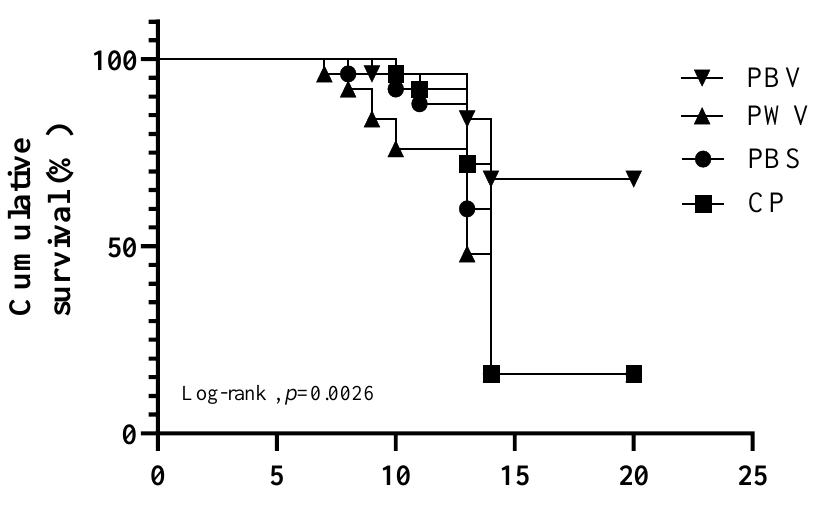
Figure 6. Effect of vaccination on cumulative survival of giant grouper infected with Photobacterium damselae subsp. damselae . The number of dead fish in each group was counted every day until no deaths were recorded for 5 consecutive days; the total mortality was then calculated. Statistical significance was determined by the log-rank test ( p < 0.0026). PBS: commercial feed with PBS. CP: commercial feed with chitosan particle. PWV: commercial feed with whole-cell vaccine. PBV: commercial feed with biofilm vaccine. Table 2. The final mortality and relative percent survival (RPS) value in vaccinated fish.